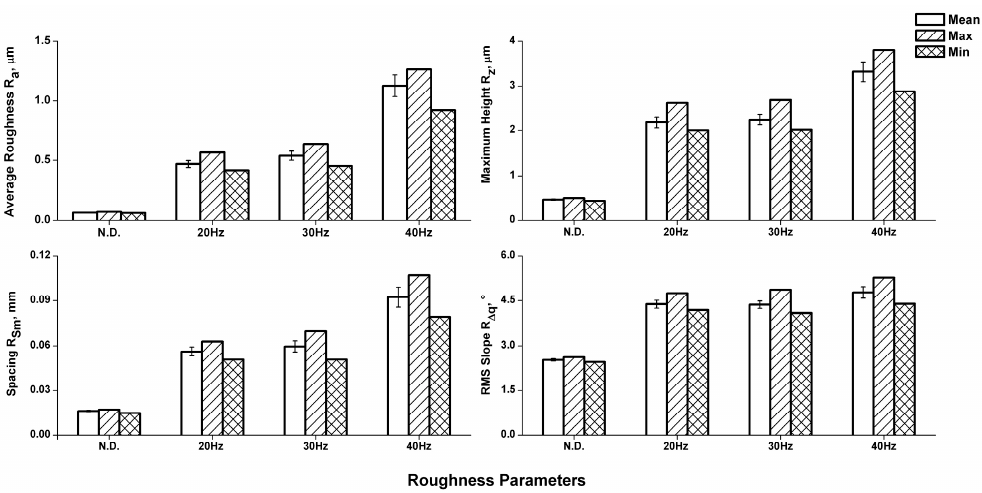
Figure 9. Roughness analysis results.